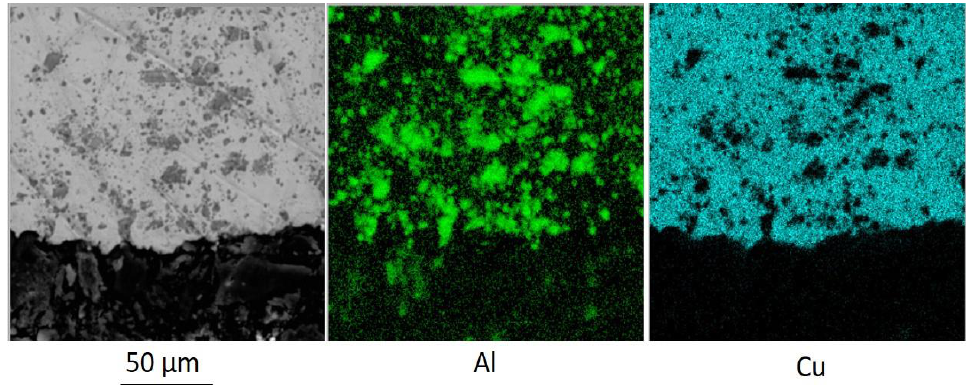
Figure 8. The microstructure and distribution maps of elements of the detached cold-sprayed Cu-60% Al 2 O 3 coating after tearing off the coating from the substrate without preprocessing.